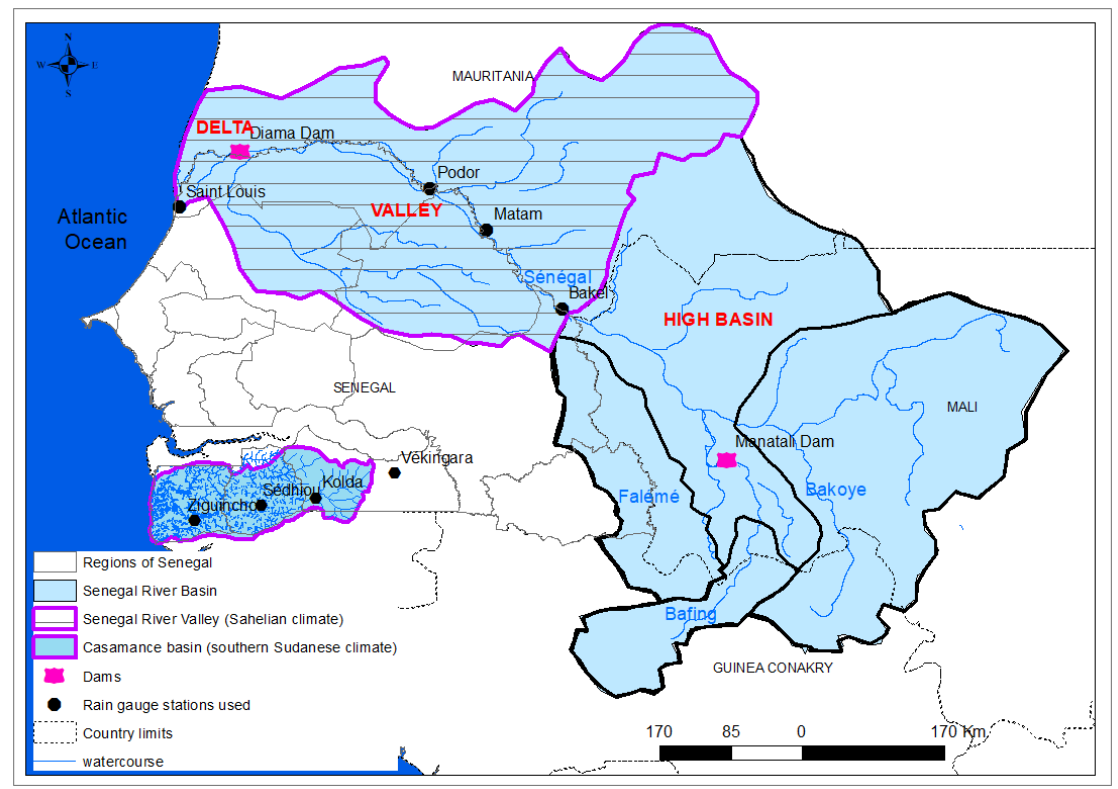
Figure 1. Presentation of the valley in the Senegal River basin, the Casamance basin and the selected stations The valley, which is the part selected in the Sahelian climate for this study, runs from the Senegal-Falémé river confluence to the traditional limit of the salt tongue rise (Rosso Mauritania); the valley itself is sometimes divided into three parts: the upper valley (between the Senegal-Falémé confluence and the Senegal-Oued Gharfa confluence, at Maghama in Mauritania), the middle valley (from the Senegal-Oued Gharfa confluence to the western limit of the Ile à Morphil in Podor) and the lower valley (from Podor to Rosso Mauritania). Data for these stations were obtained for the years 1980-2017. The study area and the location of the meteorological stations are shown in the valley located in the middle and lower Senegal River basin. Its climate is tropical, but weather conditions are extremely unpredictable. Rainfall varies greatly from one situation to another. The average annual rainfall in the valley is 300 mm